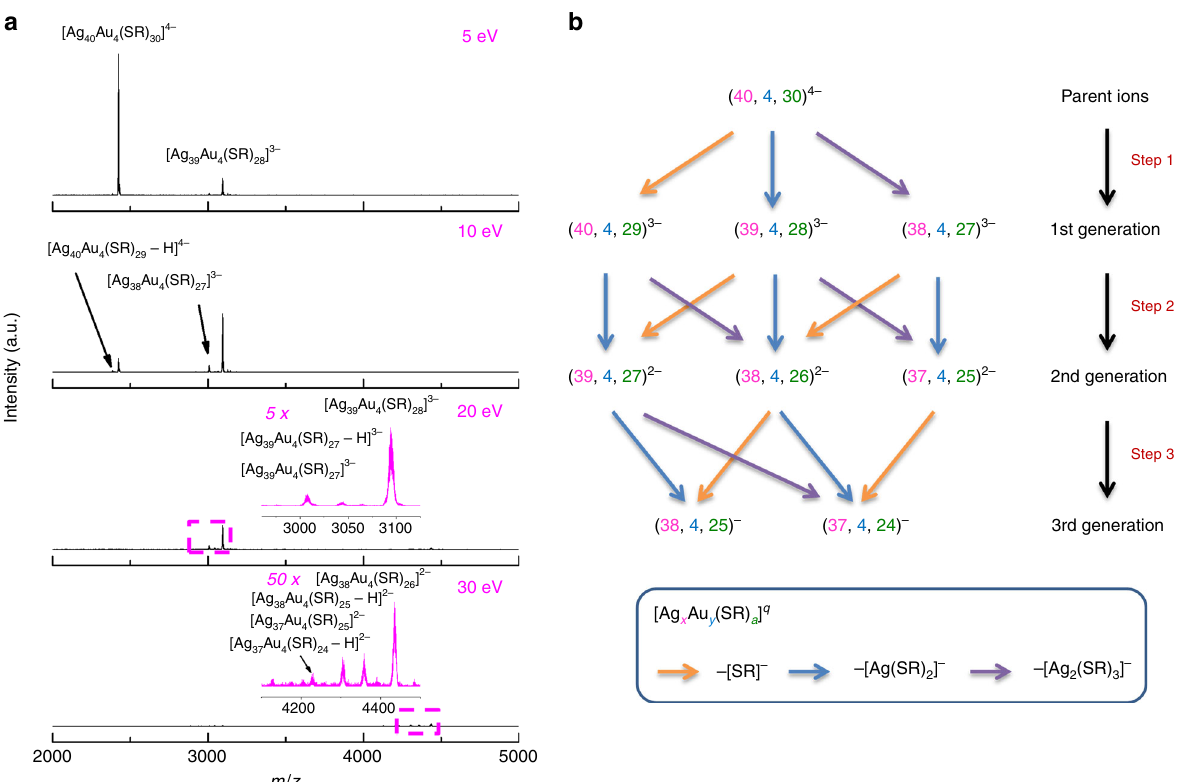
Fig. 4 Fragmentation habit of Au@Ag nanoclusters. a Tandem mass spectra and b schematic illustration of fragmentation process of Au-core/Ag-shell [Ag 40 Au 4 (SR) 30 ] 4 − (centered at m/z = 2424; SR denotes thiolate ligand) obtained at different collision energies. Insets of a are zoom-in spectra of the boxed area in the corresponding panels. The orange, blue and purple arrows in b indicate the fragmentation pathways by dissociation of SR − , [Ag(SR) 2 ] − , and [Ag 2 (SR) 3 ] − ,